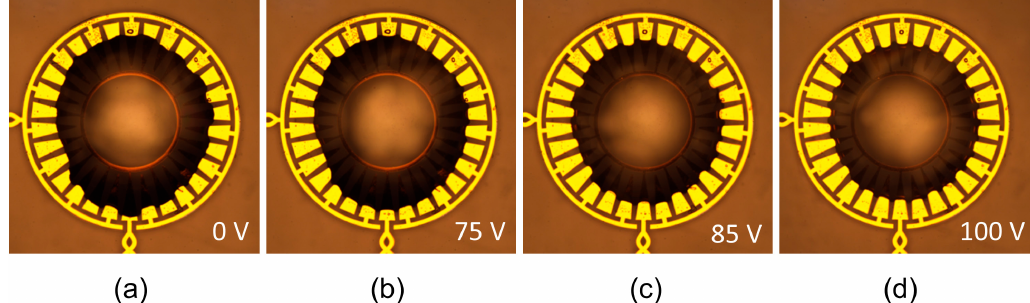
Figure 7. Top view of the silicone oil droplet surrounded by water over electrowetting electrodes. Images were taken via microscope under 5× magnification as voltage (10 kHz, AC square wave) was applied to the system. ( a ) Initial position of the oil droplet, no voltage applied; ( b ) the oil droplet begins to be squeezed by surrounding water at 75 V (RMS); ( c ) droplet when 85 V (RMS) is applied; ( d ) droplet when 100V (RMS) is applied.